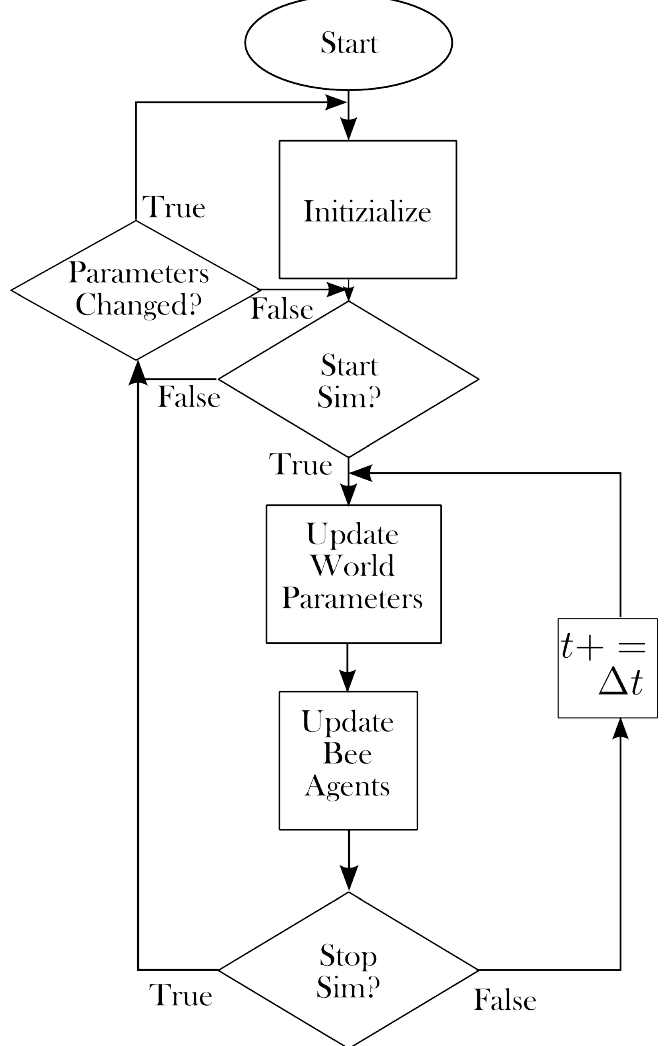
Figure 1. Flow diagram of the main program